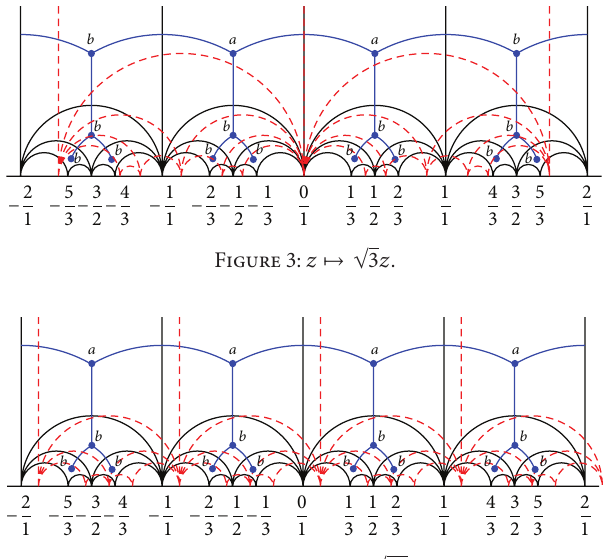
Figure 4: 𝑧 󳨃→ 𝑧 + √17